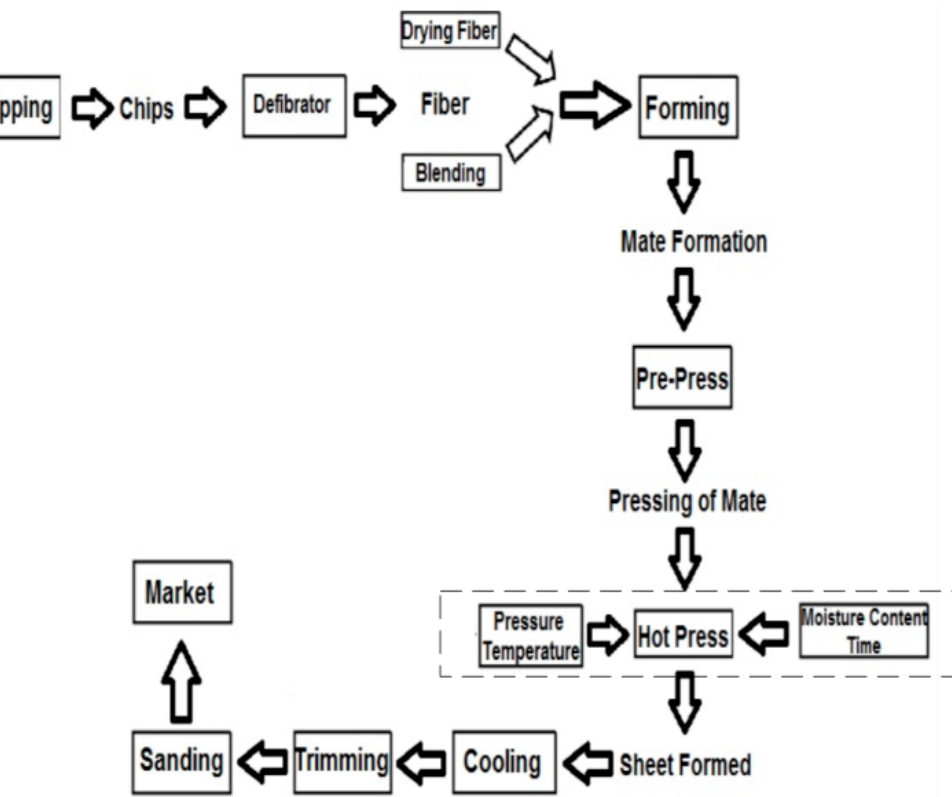
Figure 1. Medium density fiberboard manufacturing process.